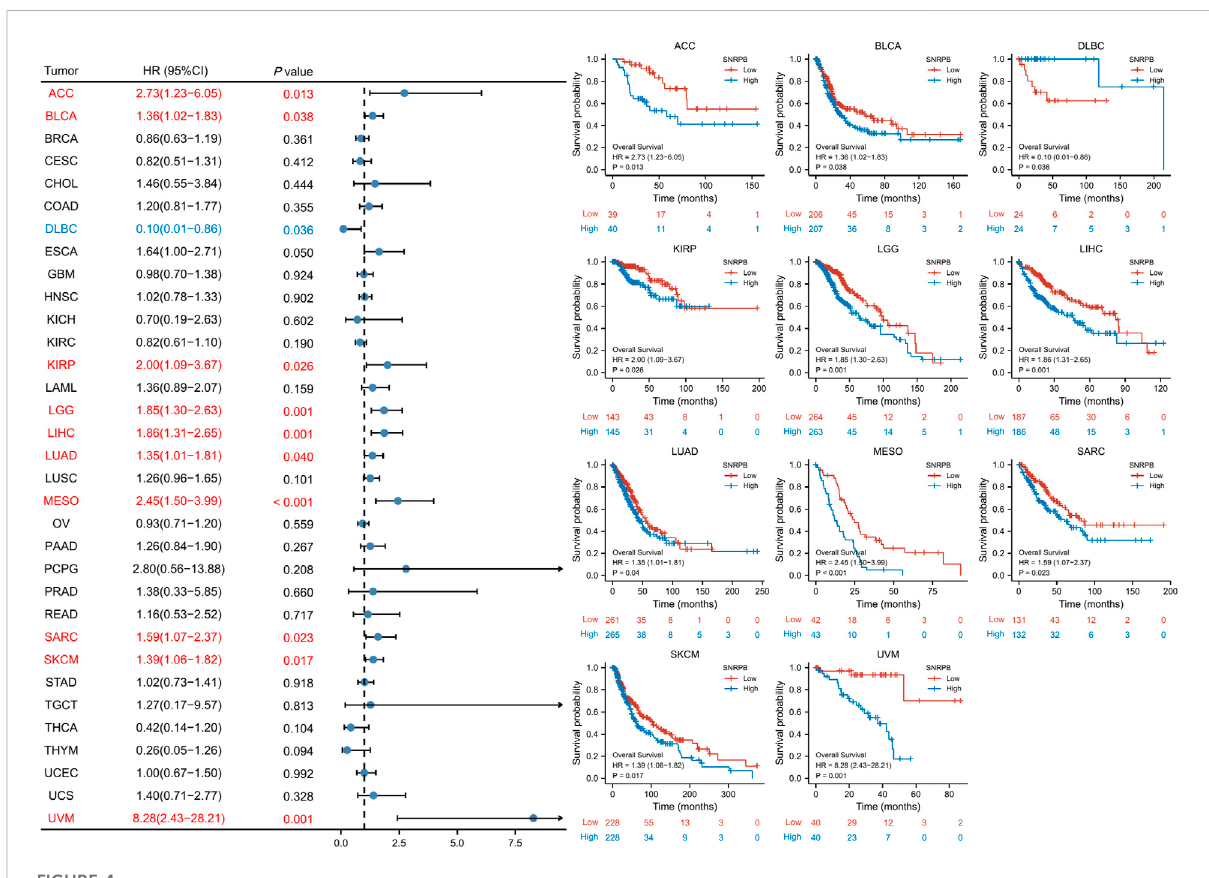
FIGURE 4 The relationship between SNRPB expression and OS across